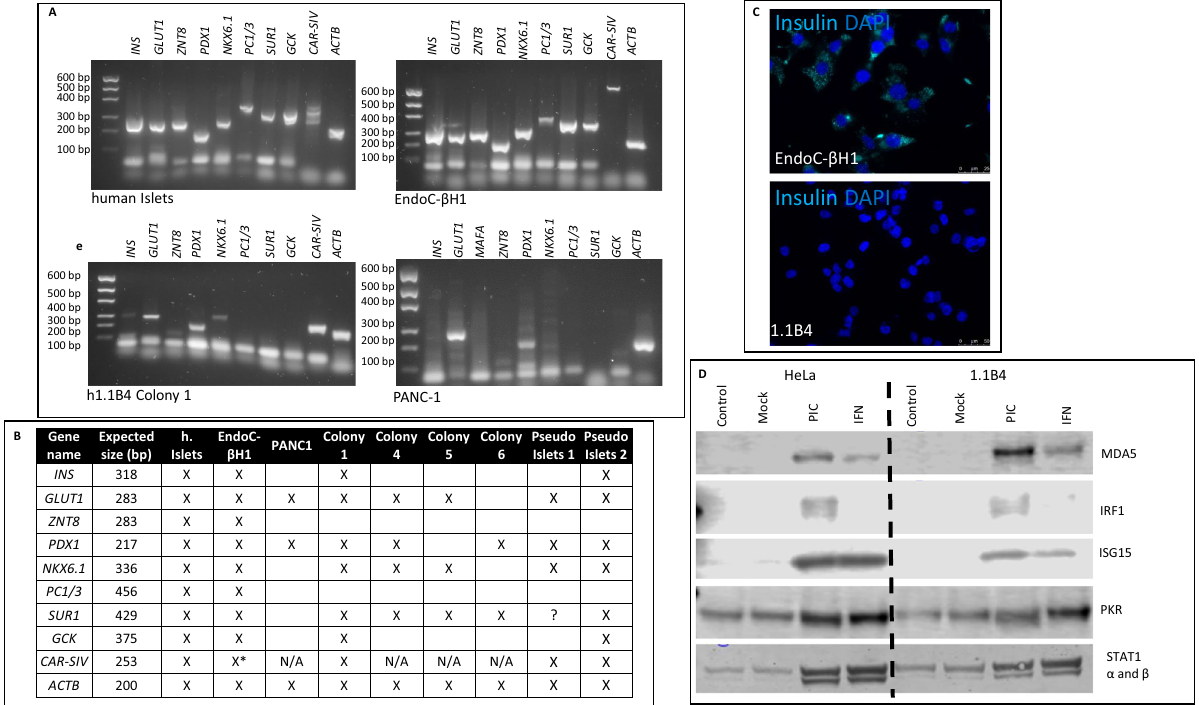
Figure 5. Gene expression profiles of expanded human 1.1B4 cell clones. ( A ) mRNA was extracted from isolated human islets, EndoC-βH1 cells, human 1.1B4 cells (data for colony 1 are shown as a representative example) and PANC1 cells. The expression of a selection of genes frequently expressed in β-cells was assessed by RT-PCR. Images of the whole gels are available in supplementary information. ( B ). Summary graphic showing the expression of a selection of β-cell genes expressed in isolated human islets, EndoC-βH1 cells, PANC-1 cells or in each of 4 colonies of expanded h1.1B4 cells (colonies 1, 4, 5, 6) configured either in monolayers or (in the case of colony 1) as pseudoislets. ( C ) Insulin expression (light blue) was investigated in EndoC-βH1 and h1.1B4 cells (colony 1) by immunocytochemistry. Nuclei were stained with DAPI (dark blue). ( D ) HeLa and h1.1B4 cells (colony 1) were treated with vehicle (control) or with interferon-alpha (IFN; 1000 U/ml) for 24 h and lysed. In parallel, additional cells were either mock transfected or transfected with polyI:C (PIC; 0.1 mg / ml) and incubated for 24 h. Western blotting was employed to monitor the expression of MDA5, IRF1, ISG15, PKR and STAT1. Images of the whole blots are available in supplementary